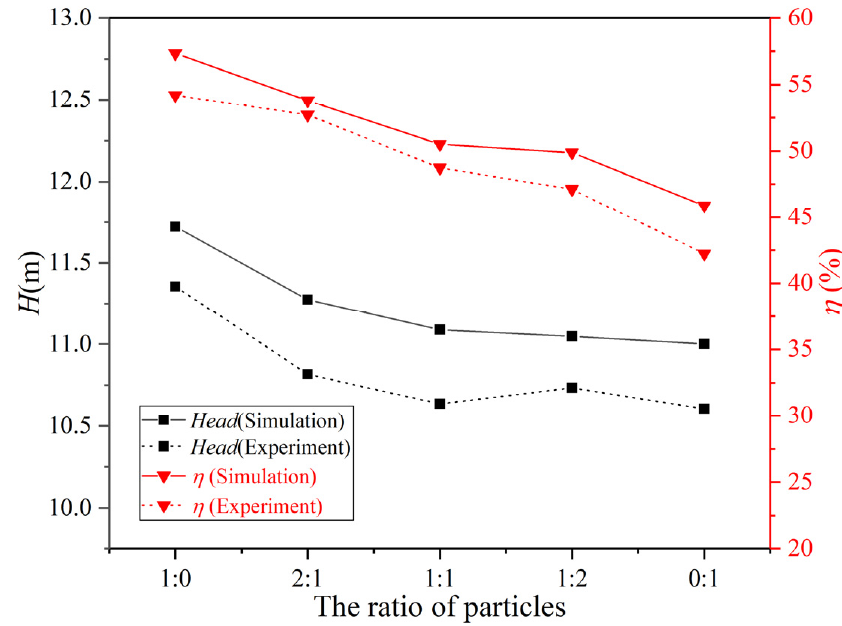
Figure 8. External characteristic curves of centrifugal pumps with different particle ratios.